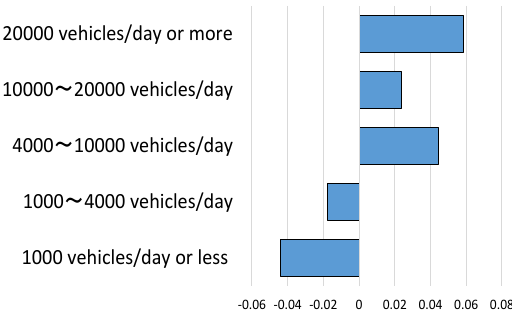
Figure 8. Daily traffic volume category scores